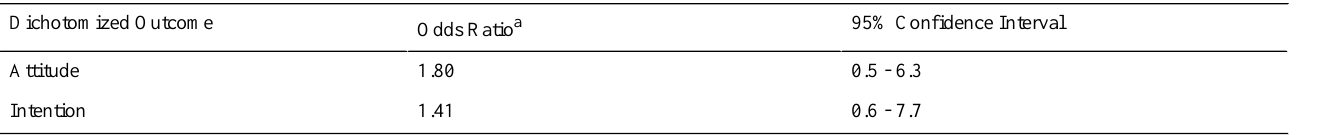
Table 5. Odds ratios showing the relationship of PSA test uptake to attitude and intention scores, dichotomized at their medians